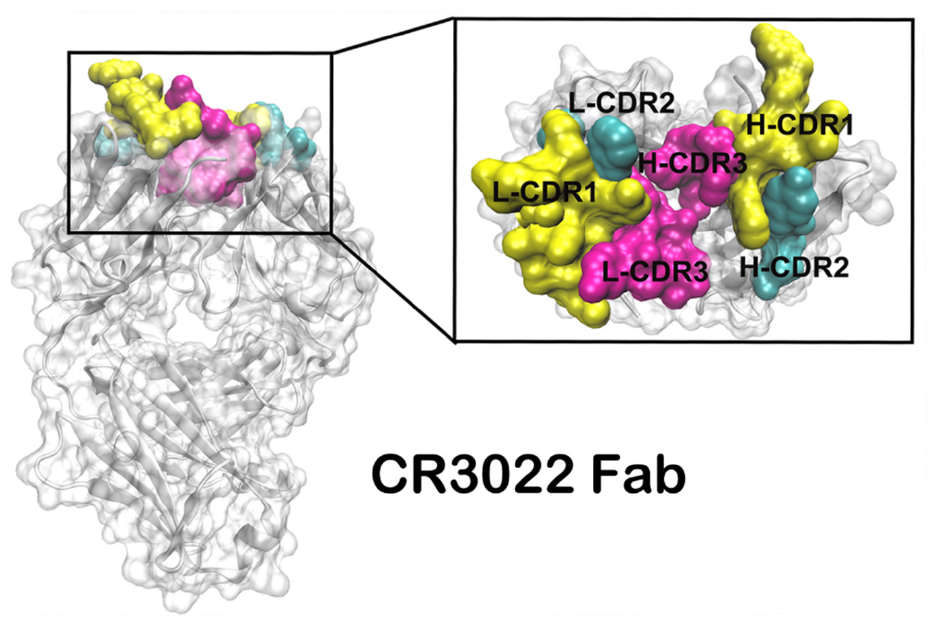
Figure 1. The ribbon diagram of the binding mode of CR3022.The light chain and heavy chain CDR1(in yellow), CDR2(in cyan), CDR3(in magenta) were highlighted in the cartoon. The image of the 3D spatial structure was generated using the Discovery Studio 4.5 software package.